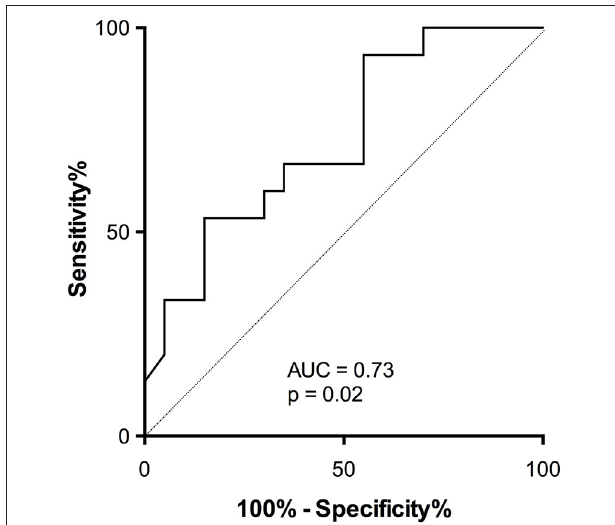
FIGURE 8 | Accuracy of activatability of cTfh17 to predict antibody response in patients on therapeutic immunosuppression. The accuracy of residual activatability of cTfh17 to identify transplant patients able to mount a TD antibody response despite immunosuppressive therapy was appreciated by plotting the Receiver Operating Characteristic (ROC) curve.